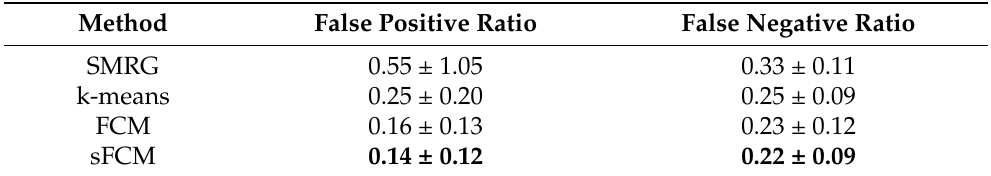
Figure 9. False Positive Ratio and False Negative Ratio boxplots. The lower and upper bounds of each box represent the first and the third quartiles of the metric distribution, respectively. The median is represented by a red line, while outliers are displayed as red crosses. Table 4. False Positive and False Negative Ratios achieved by the considered unsupervised segmen- tation approaches: the results are expressed as average value ± standard